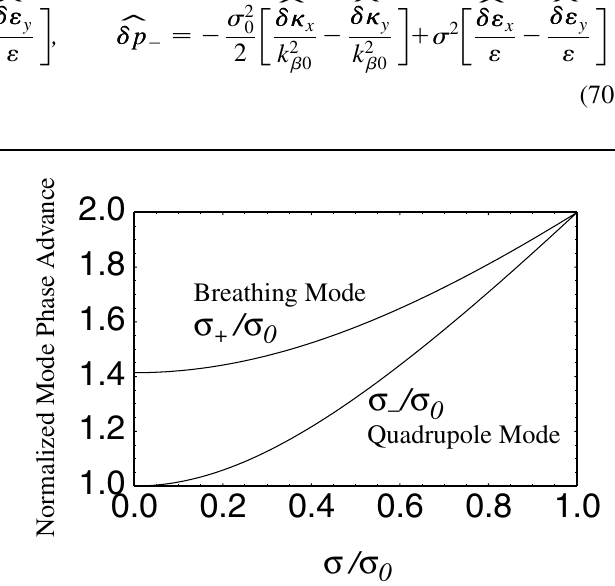
FIG. 7. Normalized phase advances (cid:24) (cid:5) =(cid:24) breathing and quadrupole modes plotted versus (cid:24)=(cid:24) continuous focusing